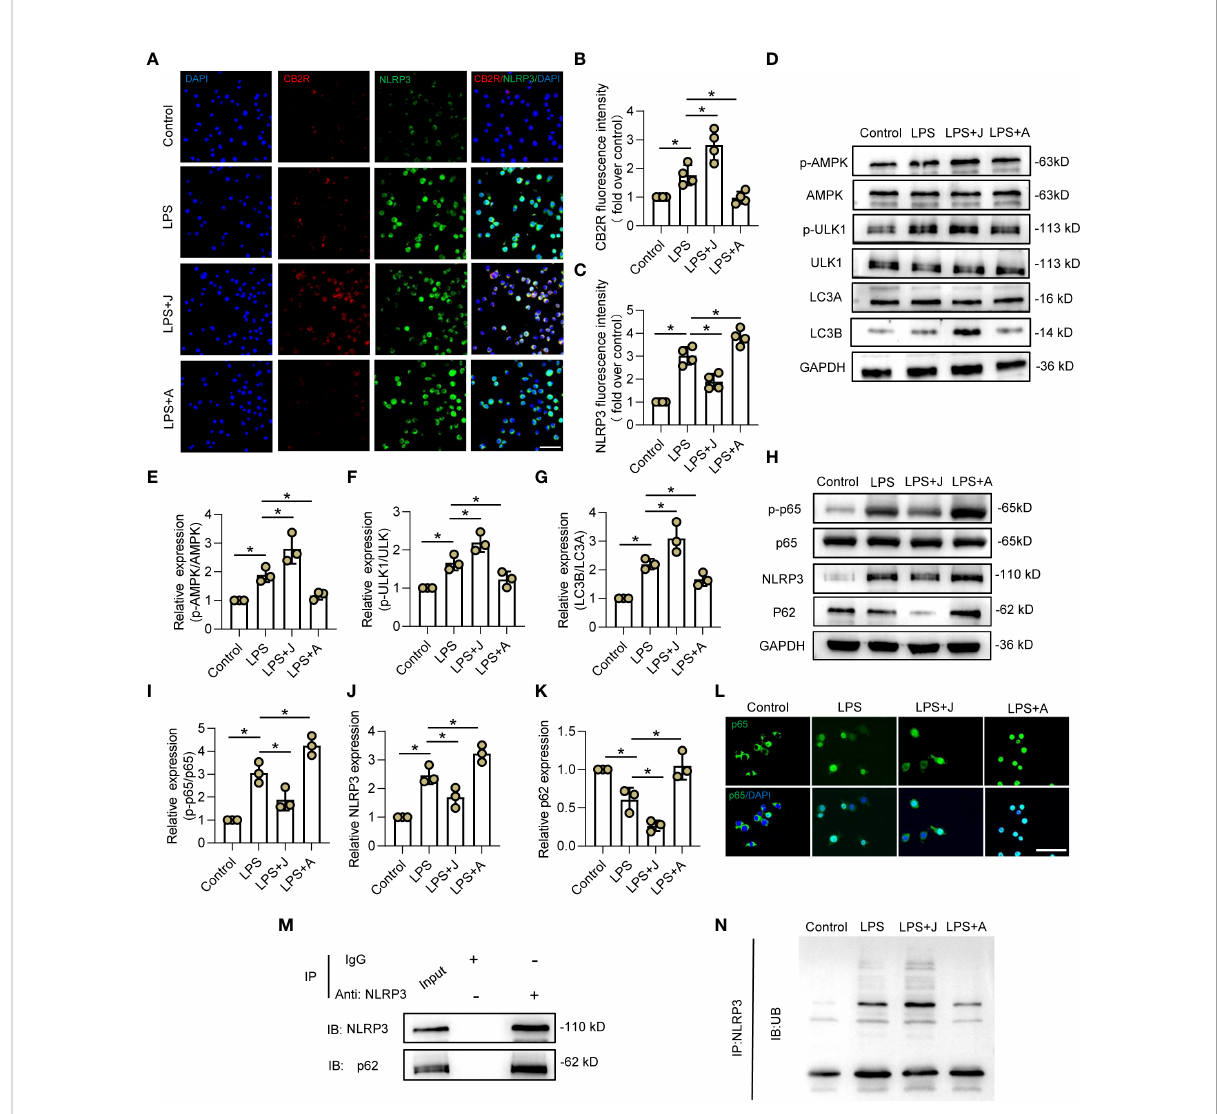
FIGURE 3 CB2R promoted ubiquitination and autophagy-induced degradation of NLRP3 via the AMPK/ULK signaling pathway. (A) IF staining of CB2R (red) and NLRP3 (green) after LPS stimuli for 24 h with CB2R activation by JWH-133 (J) or inactivation by AM630 (A) . Scale bar = 50 m m. (B) Quantitative analysis of CB2R. (C) Quantitative analysis of NLRP3. (D) Representative protein bands of p-AMPK, AMPK, p-ULK1, ULK1, LC3A, and LC3B in each group after 24 h of LPS insult. (E) Quantitative analysis of the p-AMPK/AMPK ratio. (F) Quantitative analysis of the p-ULK1/ULK1 ratio. (G) Quantitative analysis of the LC3B/LC3A ratio. (H) Representative protein bands of p-p65, p65, NLRP3, and p62 after 24 h of LPS stimulation. (I) Quantitative analysis of the p-p65/ p65 ratio. (J) Quantitative analysis of NLRP3. (K) Quantitative analysis of p62. (L) IF staining of CB2R (red) and NLRP3 (green) after LPS stimulation